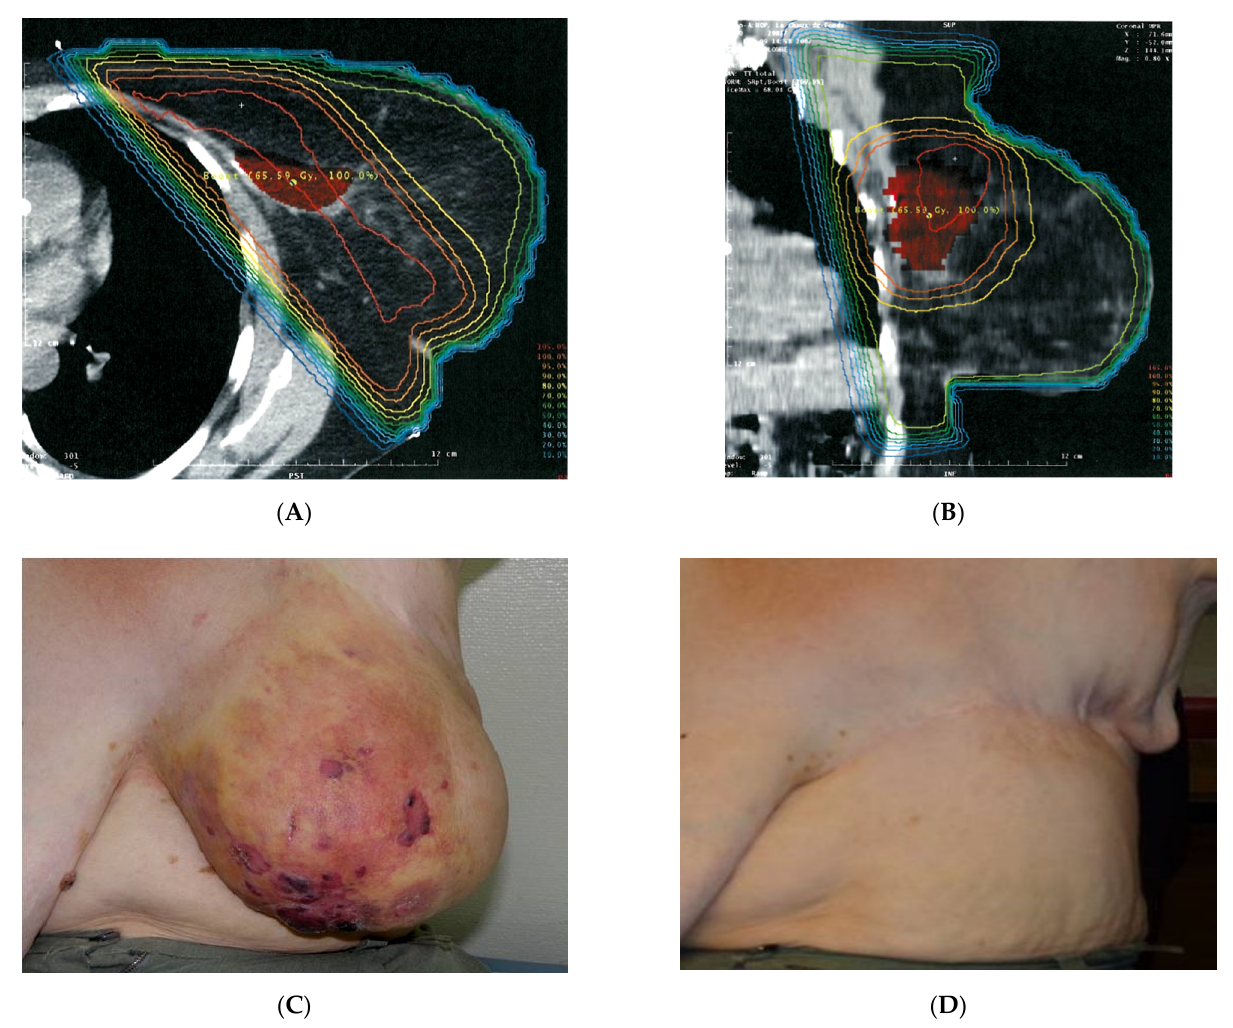
Figure 3. Documentation of patient No. 1. ( A , B ): Re-analysis of former RT 4 ½ years prior to RAASB diagnosis. 3D-planning of adjuvant breast irradiation (July 2007): Tangential irradiation of the breast with 50 Gy and boost to the former tumor bed with 16 Gy. Due to large diameter boost to the former, tumor bed was applied with parallel opposed photons field up to 16 Gy to minimize the risk of excessive skin fibrosis. ( C ): Initial RAASB: preoperative situation (August 2011). Note that the RAASB occurred all ower the breast and was not related to the former boost. ( D ): Follow up after incomplete resection (R2) and postoperative re-RT with 5 × 4 Gy + wIRA hyperthermia 1×/week (March 2014). Patient was lost to follow up after 67 months of observation. This exceptional case has been already published as a case report [31].